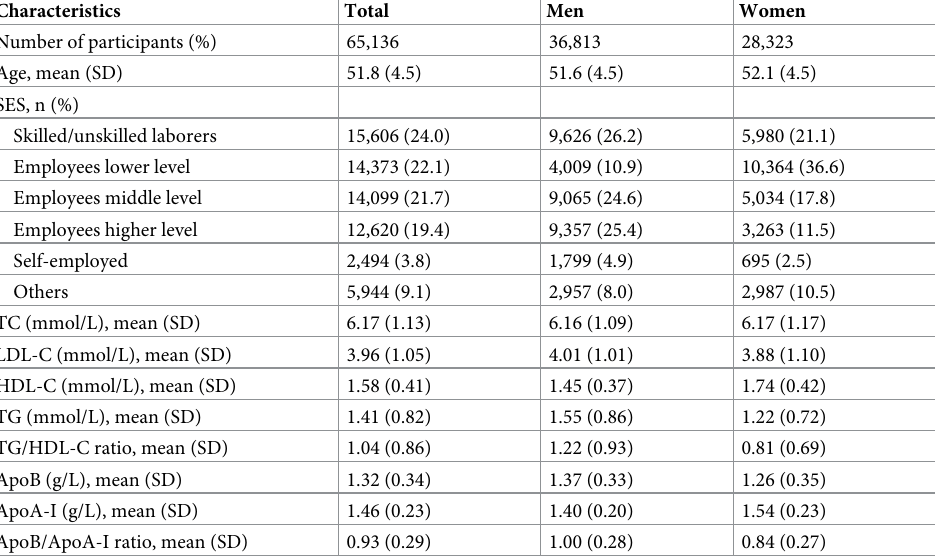
Table 1. Baseline characteristics of the study population by